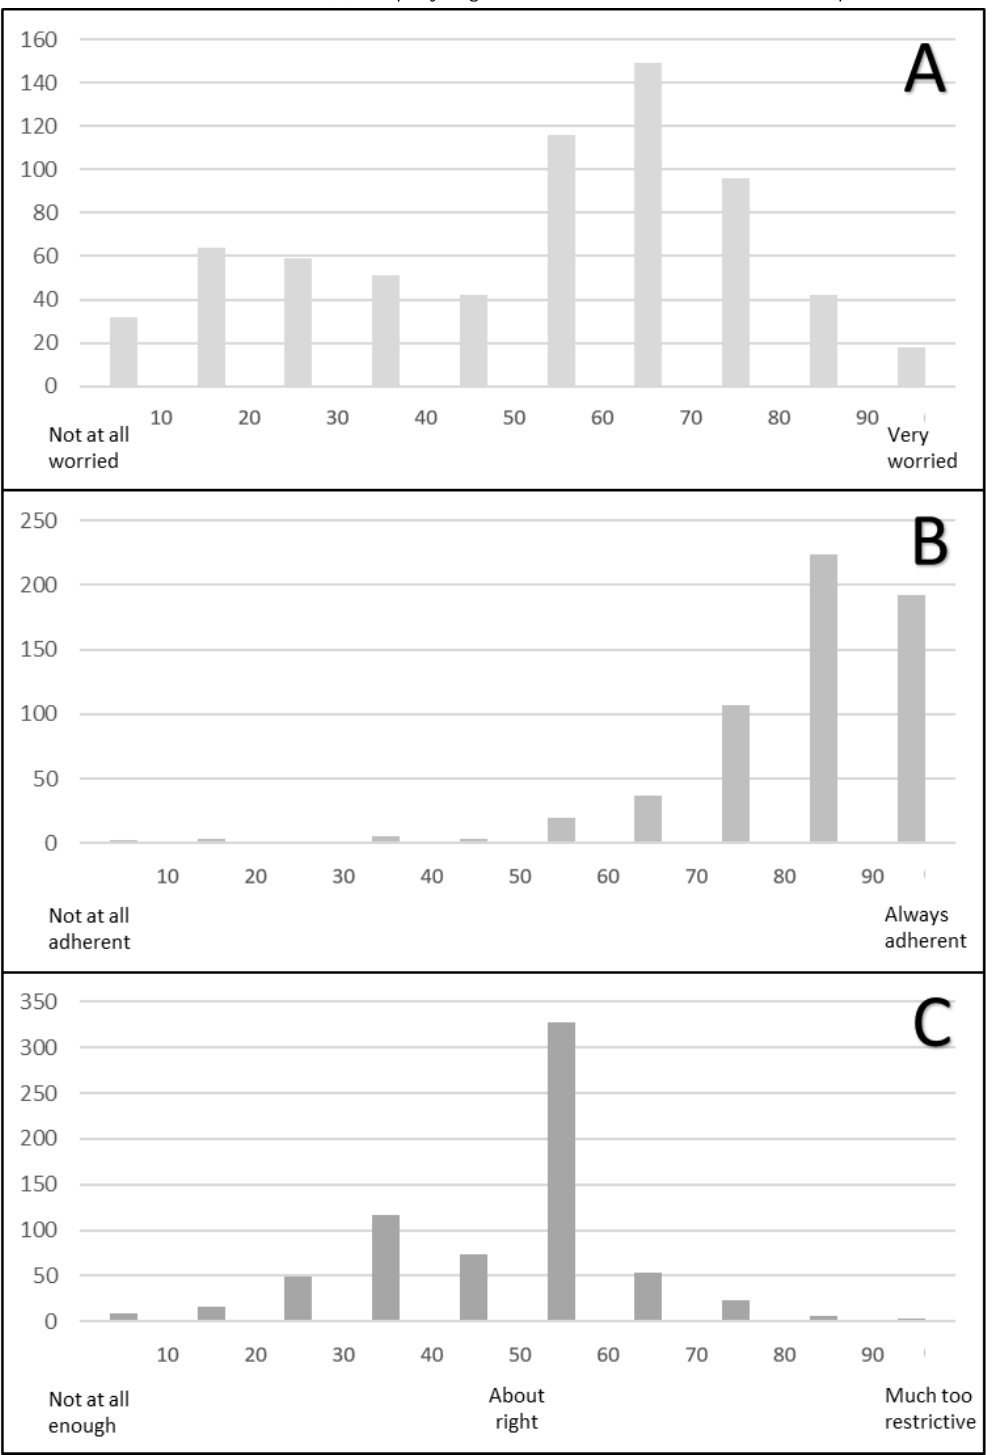
Figure 1. Distribution of participant responses to three questions using a visual analogue scale (0-100). (A) Overall worry about COVID-19. (B) Self-reported adherence to federal recommendations. (C) Adequacy of government recommendations to limit the spread of